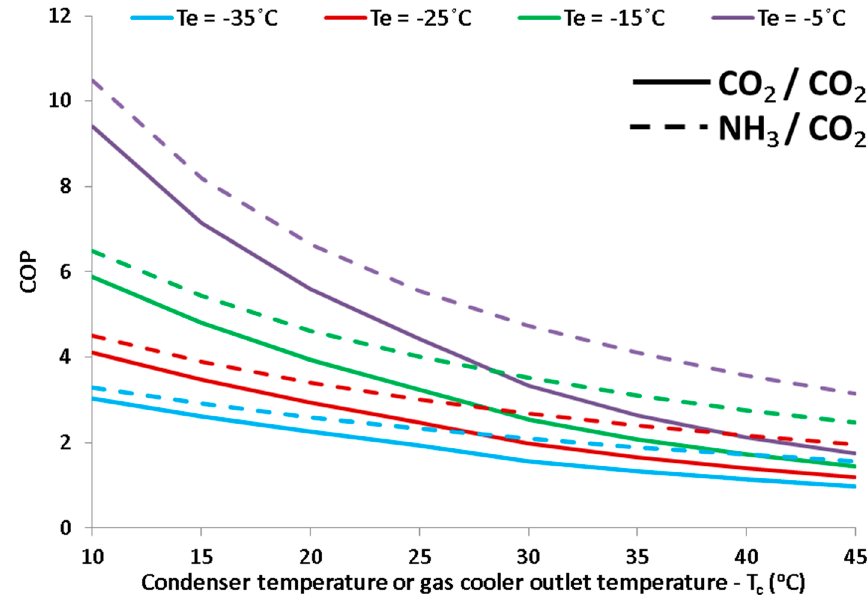
Figure 4. Coefficient of performance (COP) at different operating conditions for CO 2 /CO 2 and CO 2 /NH 3 systems.